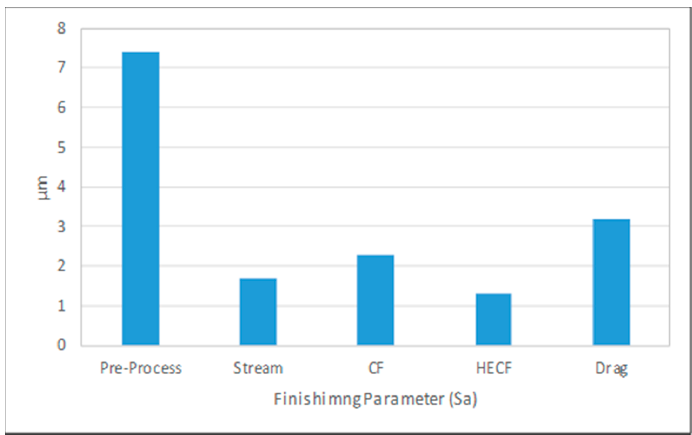
Figure 13. Sa comparison at maximum processing time of various mass finishing processes.